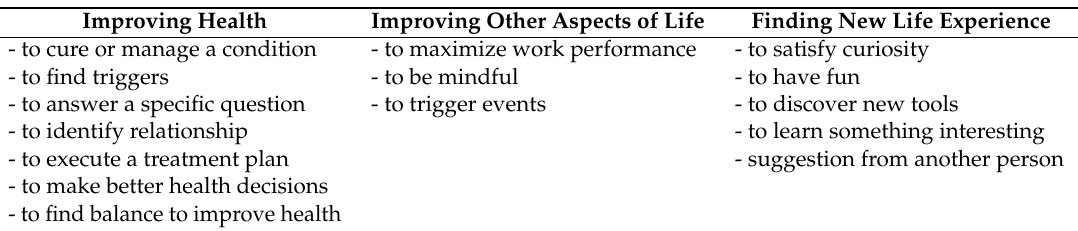
Table 1. Quantified Selfers Goals Categorization, adapted from Choe et al. This table summarizes quantified selfers’ goals into three groups with relevant